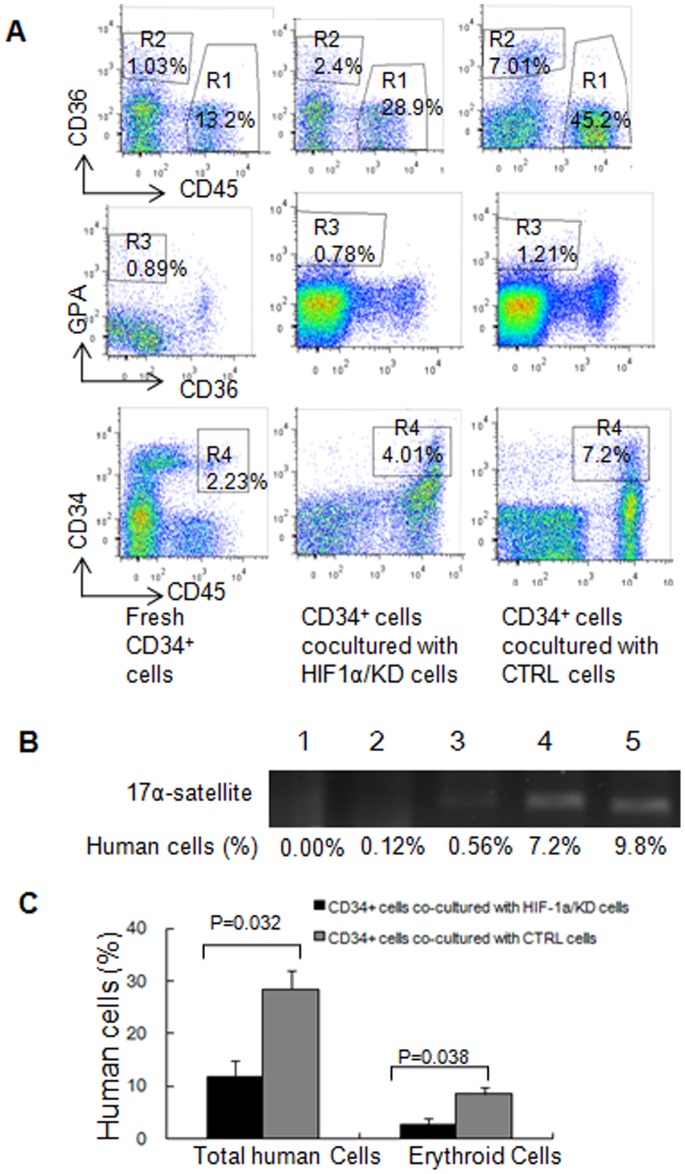
Repopulation of CD34+ cells after co-cultured with HIF1α/KD in primary and secondary NOD/SCID mice.
A: Flow cytometry analysis of the human CD34+ cell repopulation in a representative primary NOD/SCID mouse after co-cultured with HIF1α/KD or CTRL. Fresh CD34+ cells were served as controls. The mononuclear cells from bone marrow harvested from the primary injected NOD/SCID mice were examined by flow cytometry for the assessment of human cells composed of CD45+ cells (R1) and erythroid cells including CD45–CD36+ (R2) and CD36–GPA+ population (R3) and CD45+CD34+ cells (R4). B: The bone marrow mononuclear cells (MNCs) containing the different percentage of human cells (lanes 2-5) from the primary representative engrafted mice were analyzed for human-specific 17α-satellite DNA by PCR. The human-specific 17α-satellite gene was detected when the human cells were over 0.50% (lanes 3-5), whereas it was indetectable at a percentage of 0.12% (lanes 2). Lane 1, one mouse without transplants; lanes 2-3, two mice receiving transplants of fresh CD34+ cells; lane 4, one mouse receiving transplants of CD34+ cells co-cultured with HIF1α/KD cells; lane 5, one mouse receiving transplants of CD34+ cells co-cultured with CTRL cells. C: Effect of HIF-1α knockdown in 17/OE cells on repopulation of CB CD34+ cells in secondary NOD/SCID mice. Human cells were analyzed in secondary mice 12 weeks after intravenous injection of bone marrow cells from primary mice, which were injected with CB CD34+ cells co-cultured with HIF1α/KD or CTRL for 4 weeks and sacrificed 8 weeks after transplantation. The percentage of total human cell or erythroid cells in the secondary BM from the primary recipient transplanted with CD34+ cells co-cultured with HIF1α/KD was significant lower than that from the primary recipient transplanted with CD34+ cells co-cultured with CTRL (p = 0.032 and 0.038 respectively) (Student’s t-test).